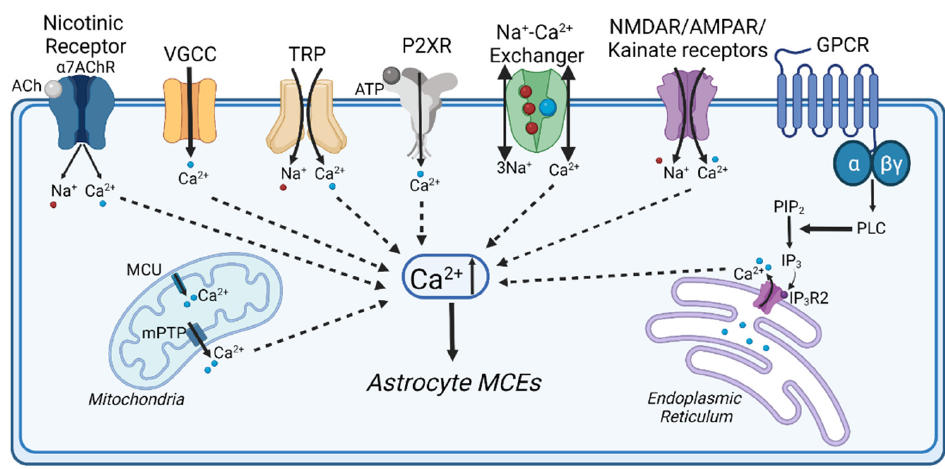
Figure 2 . Astrocyte Ca 2+ pathways activated during synaptic transmission . This diagram high- Figure 2. Astrocyte Ca 2+ pathways activated during synaptic transmission. This diagram highlights lights the pathways that involve extracellular Ca 2+ influx as discussed in this review. the pathways that involve extracellular Ca 2+ influx as discussed in this